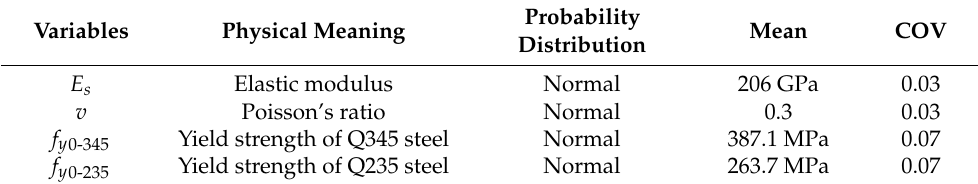
Table 1. Statistical characteristics of random parameters.